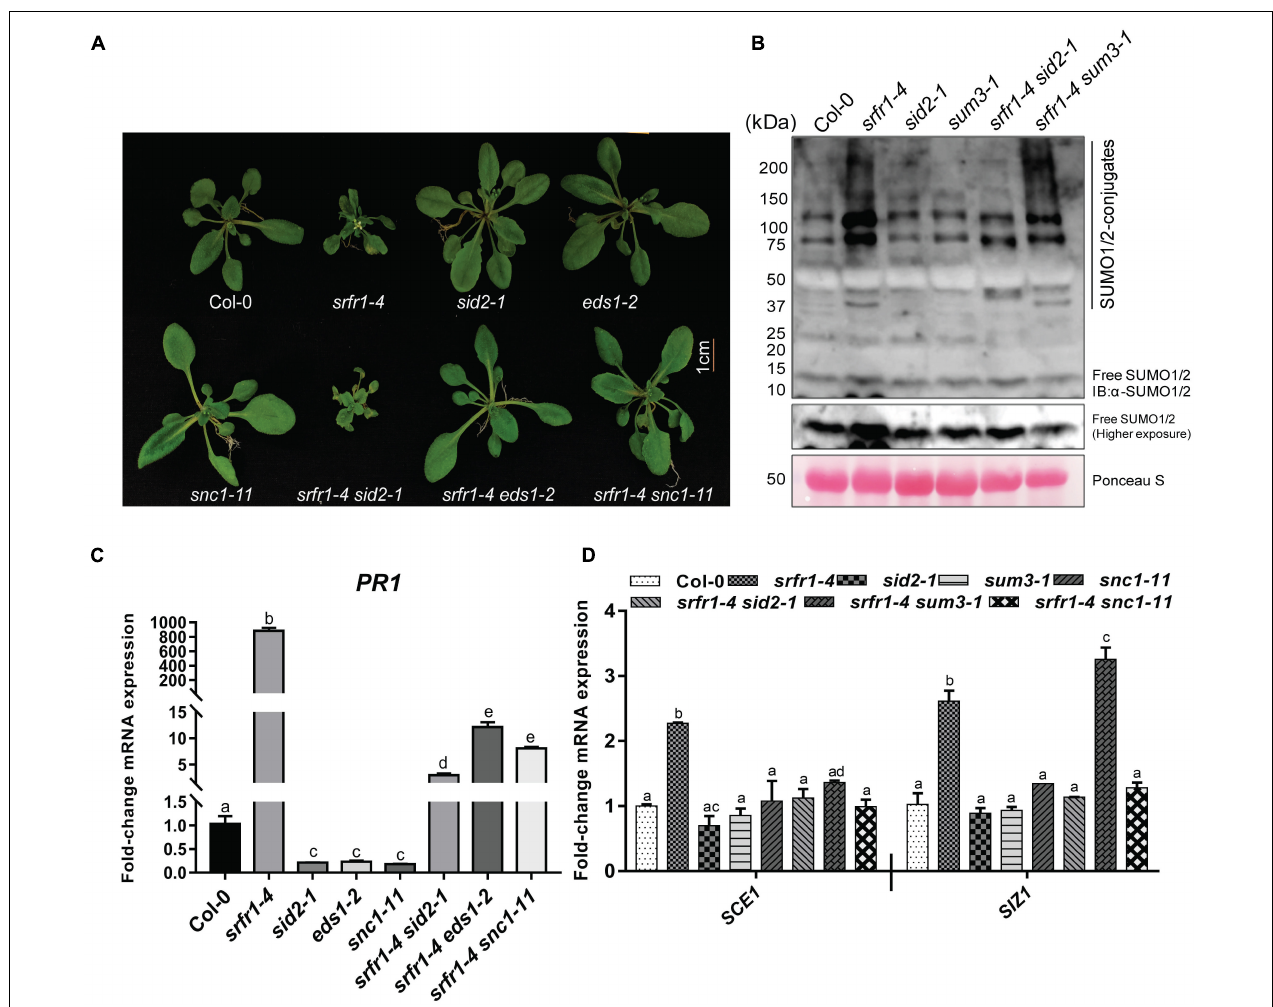
FIGURE 2 | SUMOylome enhancements but not growth defects in srfr1-4 are SID2/ICS1 -dependent. (A) Growth phenotypes of 4-week-old Col-0, srfr1-4 , srfr1-4 sid2-1 , srfr1-4 eds1-2 , srfr1-4 snc1-11 , sid2-1 , eds1-2 , and snc1-11 plants. Scale bar = 1 cm. (B) Immunoblot of SUMO1/2-conjugates and free SUMO1/2 in indicated plant genotypes. Protein extracts were probed with anti-SUMO1/2 antibodies. Ponceau S staining is indicative of loading controls. Transcript abundance of (C) PR1 , (D) SCE1 , or SIZ1 , is relative to control MON1 expression in the indicated genotypes ( n = 3). Values are mean ± SD and shown as fold-change relative to Col-0 levels. Different letters indicate statistical differences according to post hoc Tukey’s test ( p <